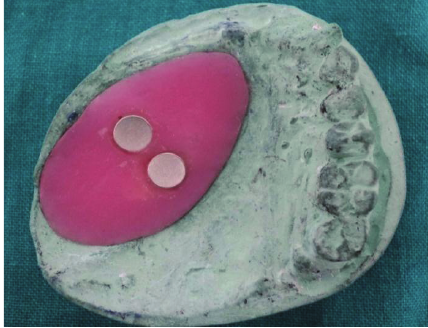
Figure 12: Finished bulb with magnets.